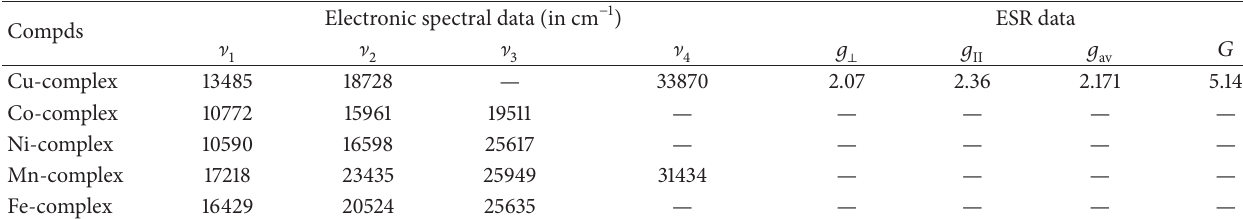
Table 3: Electronic and EPR spectral data of complexes of the ligand